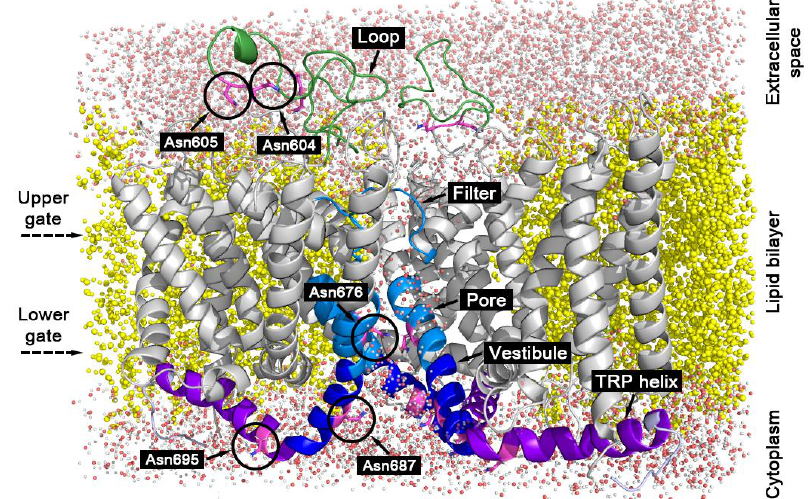
Figure 1. Ribbon representation of TM segments of TRPV1 embedded into hydrated lipid bilayer (three protein subunits are shown). The protein domains considered in the analysis of water dynamics are colored: green—extracellular loops (residues 604–625), blue—pore segment of the helices S6 (residues 670–680), and selectivity filter (residues 642–646), dark blue—vestibule segment of the helices S6 (residues 681–692), purple—TRP helices (residues 693–711), gray—other protein parts. Asparagine residues of TRPV1 further mentioned in the text are marked by black circles. Yellow—lipid bilayer, red and white dots—water molecules. Dashed arrows mark the levels of the upper and the lower gates.